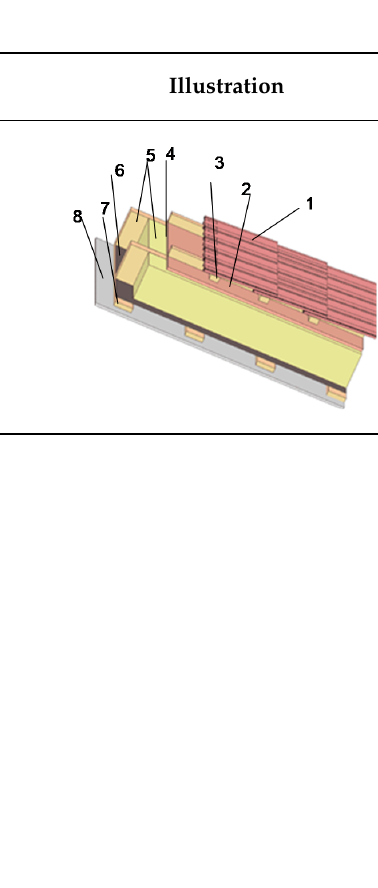
Figure 3. Porch—external open space outside limited by poles or pillars (Silesia, Poland).